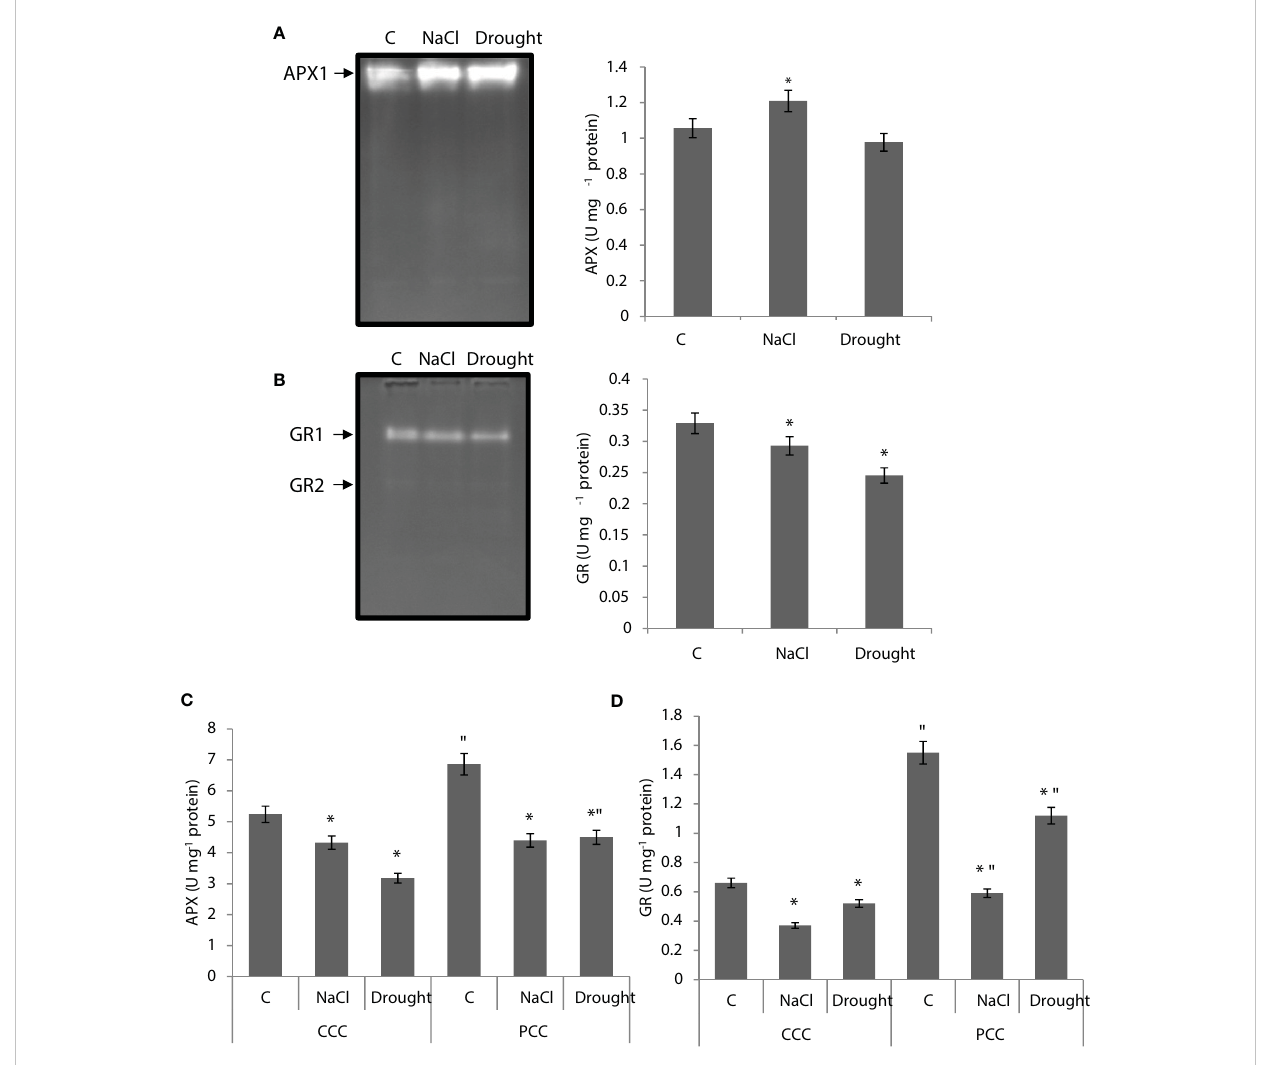
FIGURE 6 (A) Ascorbate peroxidase (APX) native activity gel and total APX activity of whole leaves. (B) Glutathione reductase (GR) native activity gel and GR activity of whole leaves. (C, D) APX and GR activities of CCC and PCC of Bienertia sinuspersici treated with 400 mM NaCl or water withholding for 10 d. “ * ” indicates signi fi cant difference (p < 0.05) as compared to controls. For CCC and PCC groups are compared to their own controls. When effects of treatments are compared between CCC and PCC, signi fi cant differences are shown with “